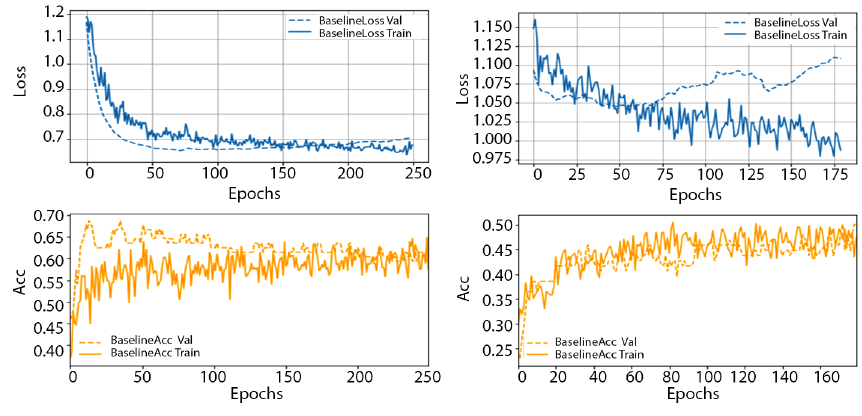
Figure 4. Classification: Left – exp E1a), right – exp E2a), classification in classes with observations from one